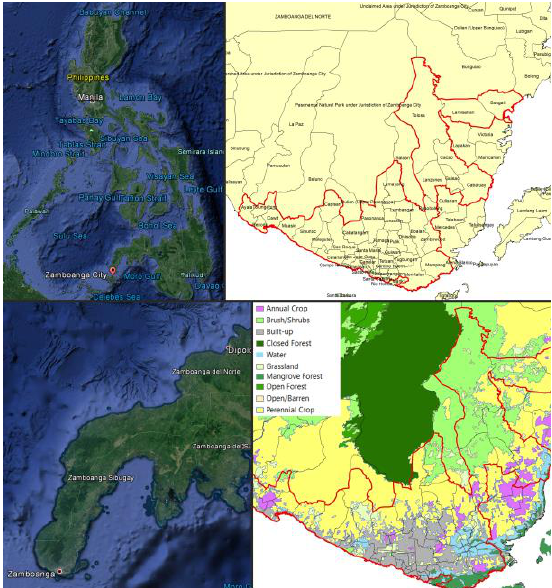
Figure 1. Google Earth image showing location of Zamboanga City (left images), the 49 barangays (right images) covered in the study area (red polygon) and land cover map from the National Mapping and Resource Information Authority (bottom right). Barangay boundary data is from the Philippine Statistics Authority boundary.